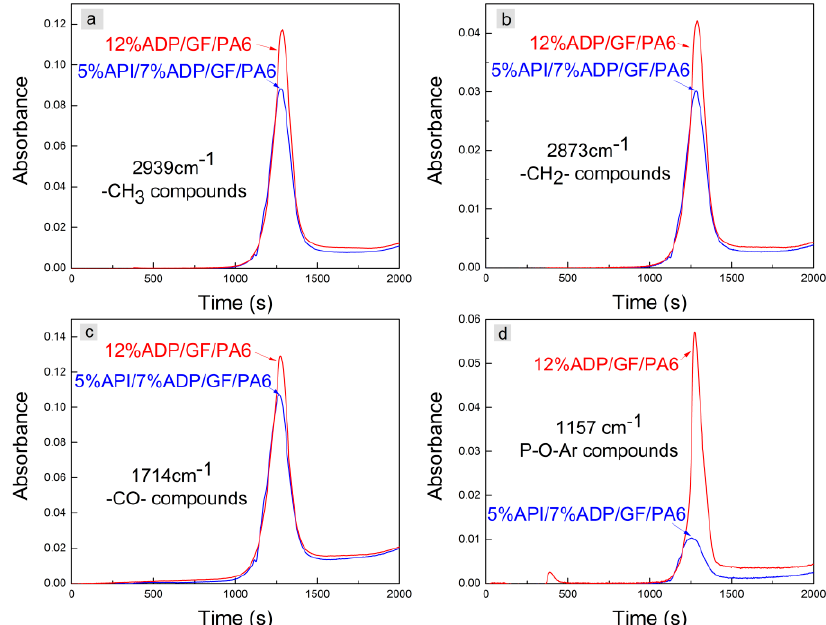
Figure 6. Intensity-time curves of typical absorption peak in real-time FTIR spectra of TGA pyrolysis gases of 5%API/7%ADP/GF/PA6 and 12%ADP/GF/PA6. ( a ) –CH 3 compounds; ( b ) –CH 2 – compounds; ( c ) –CO– compounds; ( d ) P–O–Ar compounds.